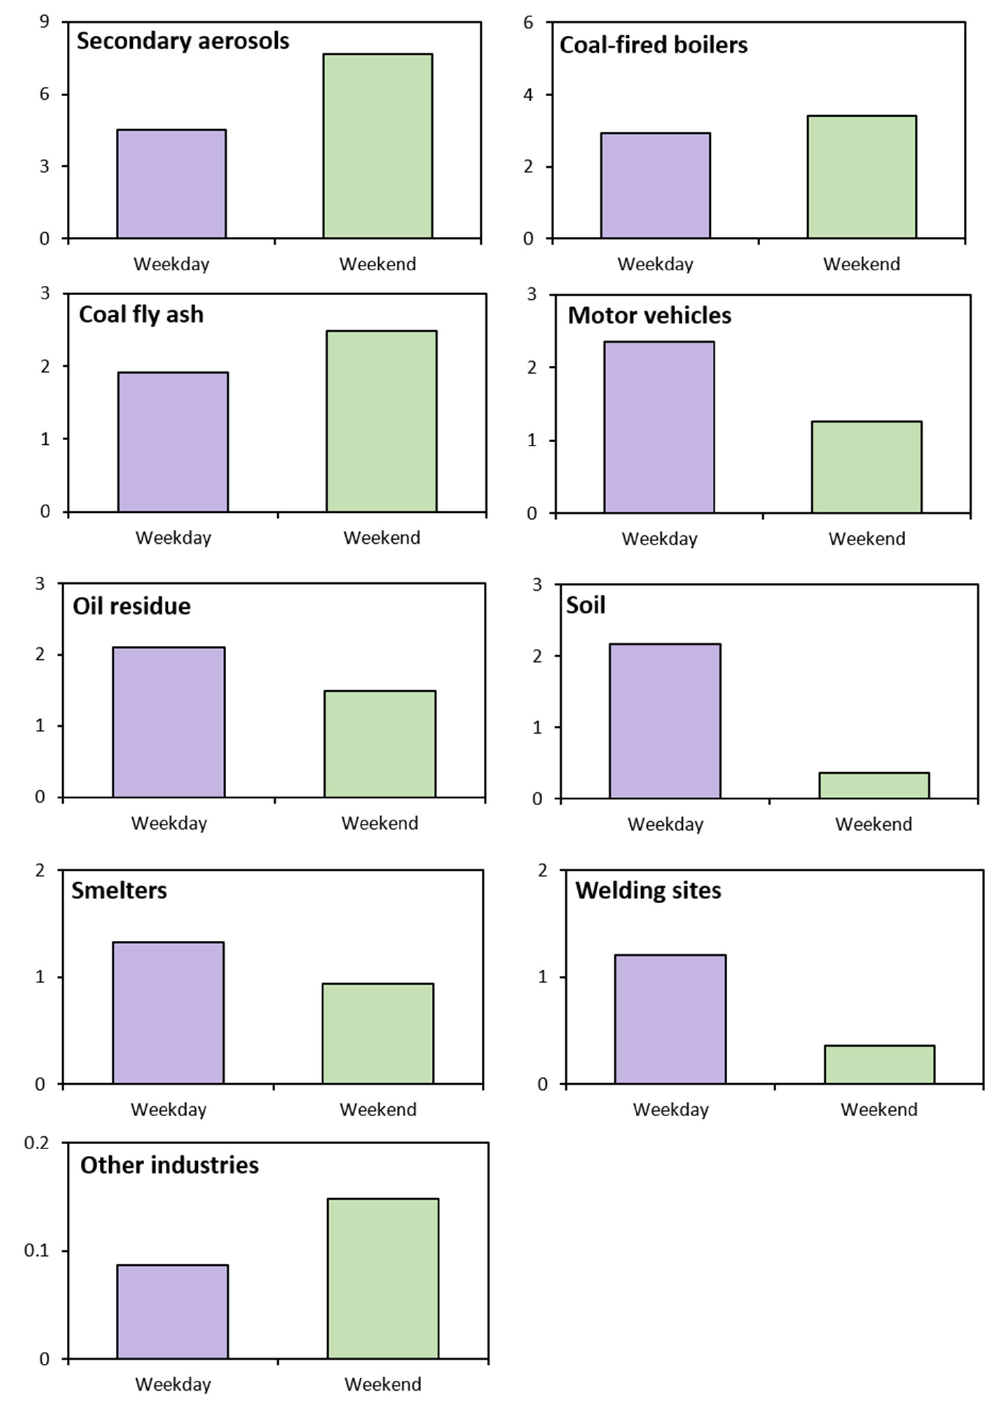
Figure 5. Difference in source contribution to PM 2.5 between weekdays and weekends.